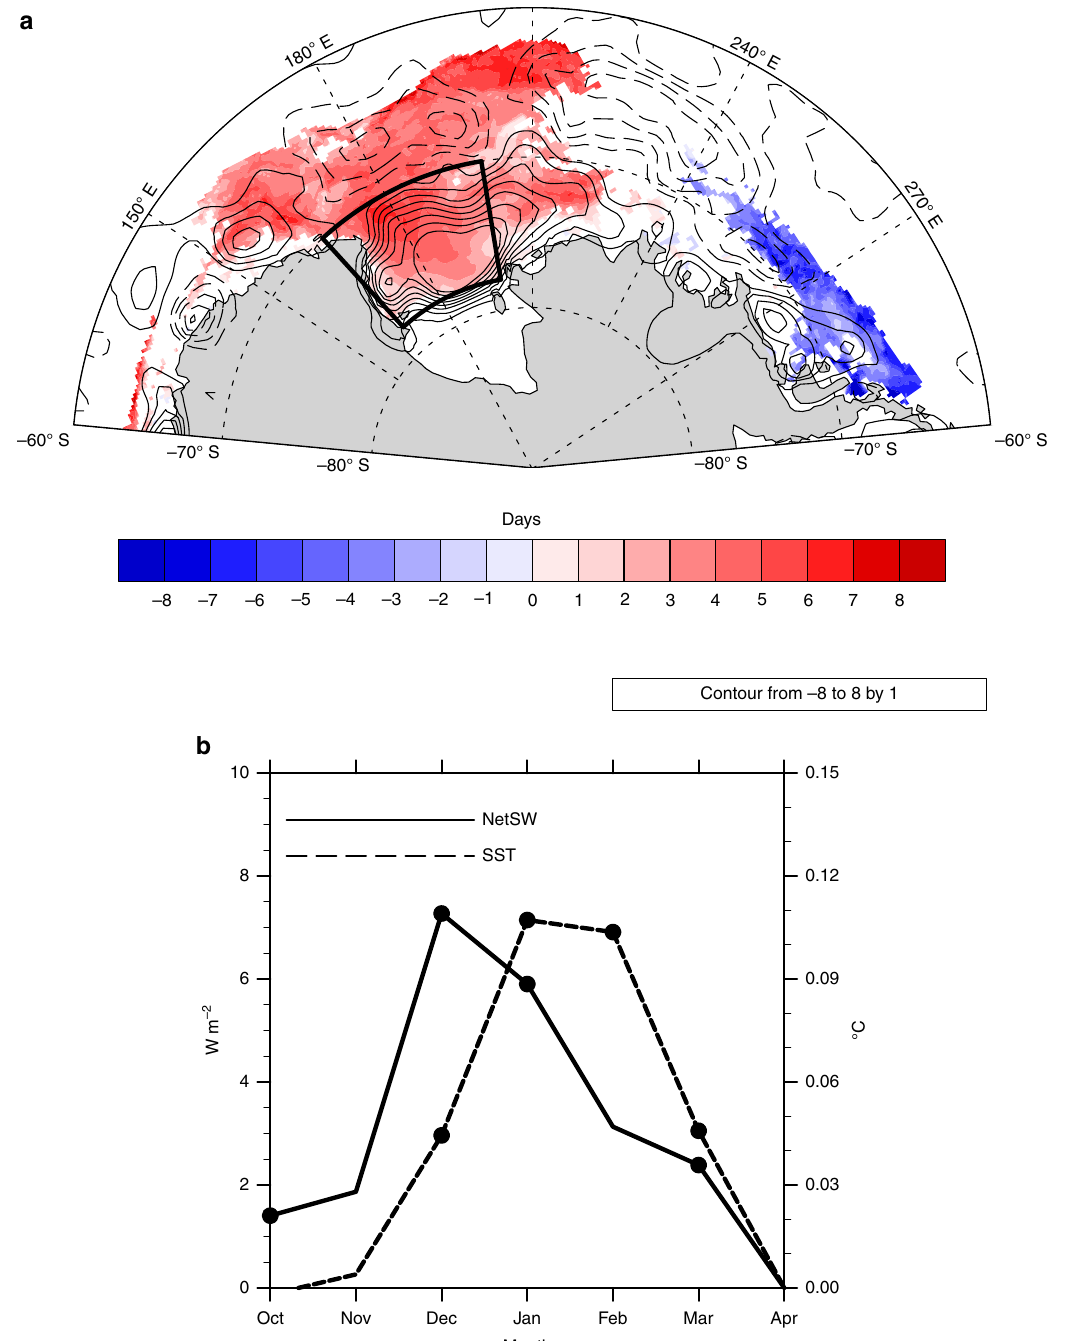
Fig. 4 The relationship of environmental properties to the preceding October zonal winds. a Regression of 1979 – 2015 surface net shortwave radiation averaged from December to February ( black contours ) and the timing of ice advance ( colored shading ) on the normalized and detrended prior October zonal wind index. The net shortwave regression is contoured at 1 W m − 2 , negative values are dashed , and the zero line omitted. Regression of ice advance is only shown where signi fi cant at the 95% level. b Regression of monthly 1979 – 2015 net shortwave ( solid ; left axis) and 1982 – 2015 SST ( dash ; right axis) averaged in the region denoted by the box on a on the normalized and detrended October zonal wind index. Signi fi cant values are denoted by the